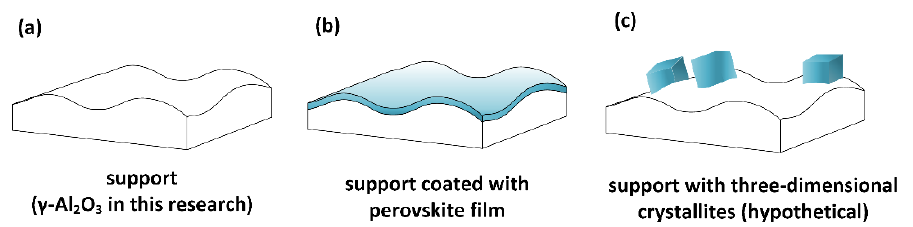
Figure 4. Morphology of the CaTiO 3 film on the surface of the Al 2 O 3 support. ( a ) Bare support; ( b ) support coated with a uniform film; ( c ) support decorated with three-dimensional cubic crystallites.